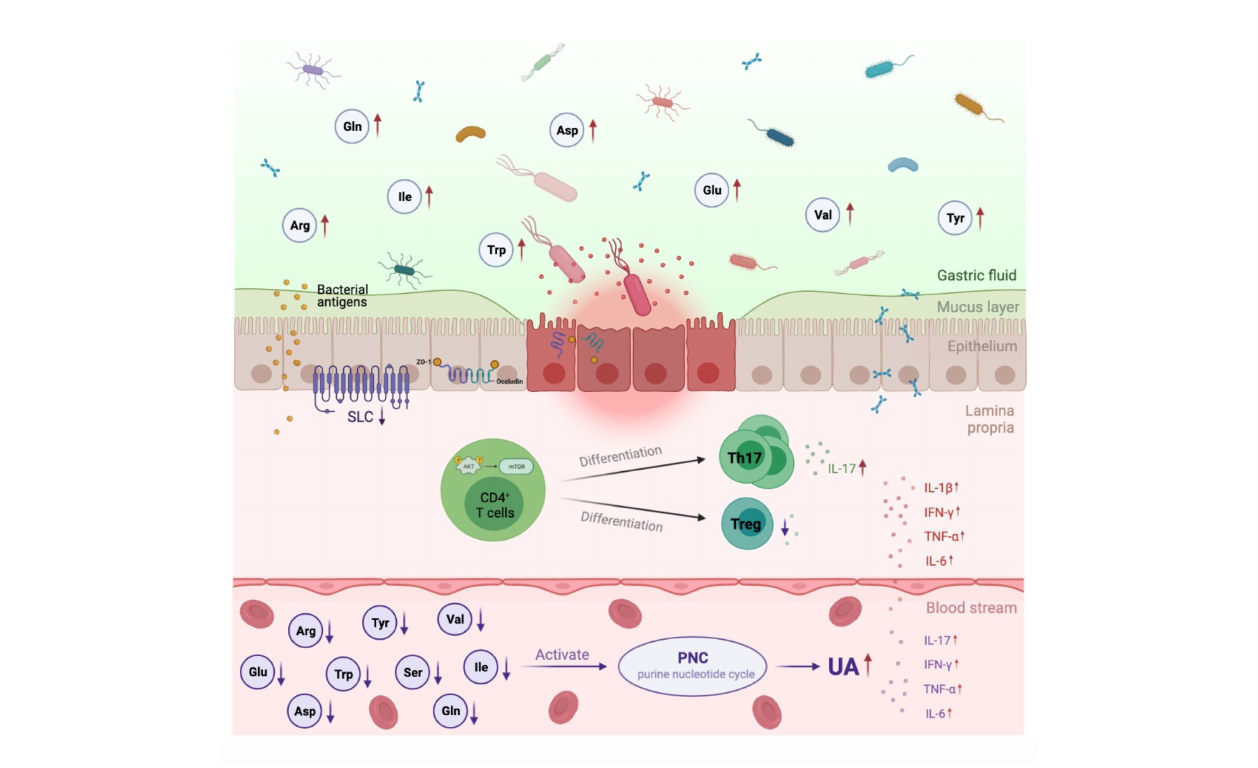
FIGURE 6 | Proposed mechanism of perturbed gut microbiome in pathogenesis of HUA and gout. In Uox -KO mice, altered intestinal micro fl ora composition and function resulted in the impairment of intestinal integrity and the disorder of SLCs family expression, which subsequently led to the dysfunction of AA transportation and the decreased serum levels of valine, isoleucine, glutamine, arginine, tryptophan and tyrosine. De fi ciency of serum amino acids further in fl uenced purine nucleotide cycle and differentiation of CD4 + Th17, and eventually contributed to the occurrence and development of HUA and gout. Red arrow indicates upregulation, purple arrow indicates